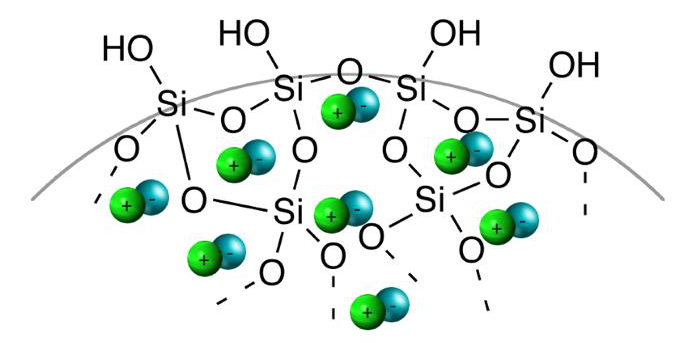
Figure 3. Ionic liquids moieties entrapped in the silica pores.